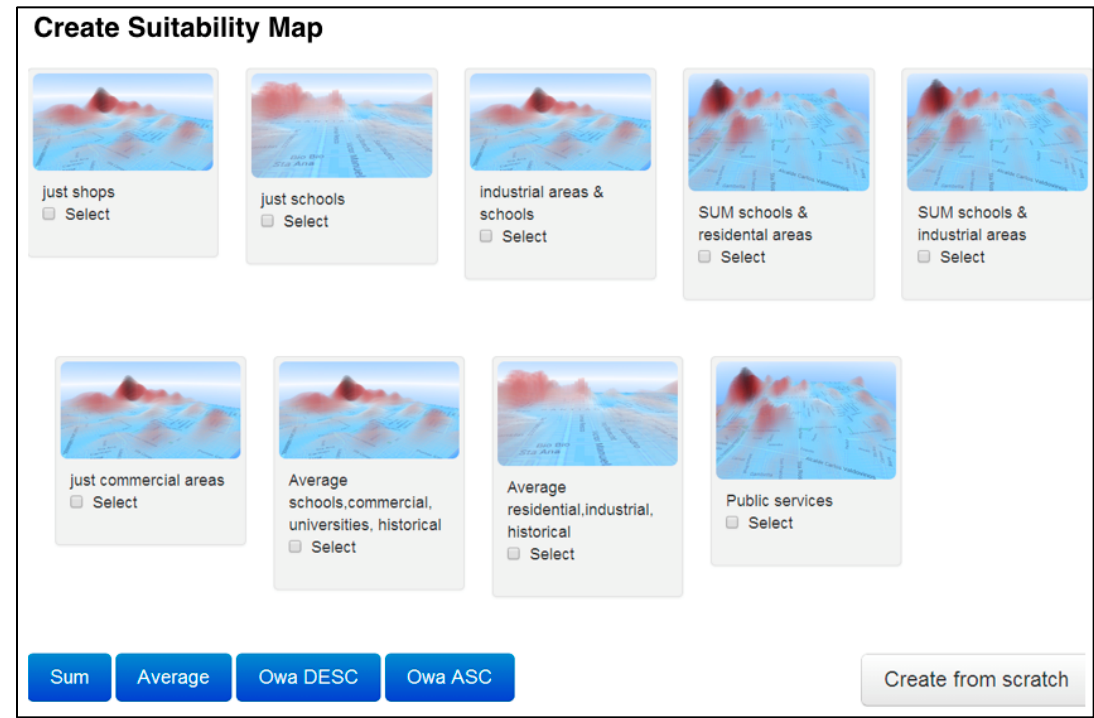
Figure 5. Creating a new suitability map by applying operators to existing ones. The user selects which maps to combine and then presses the button labeled with the desired operation.